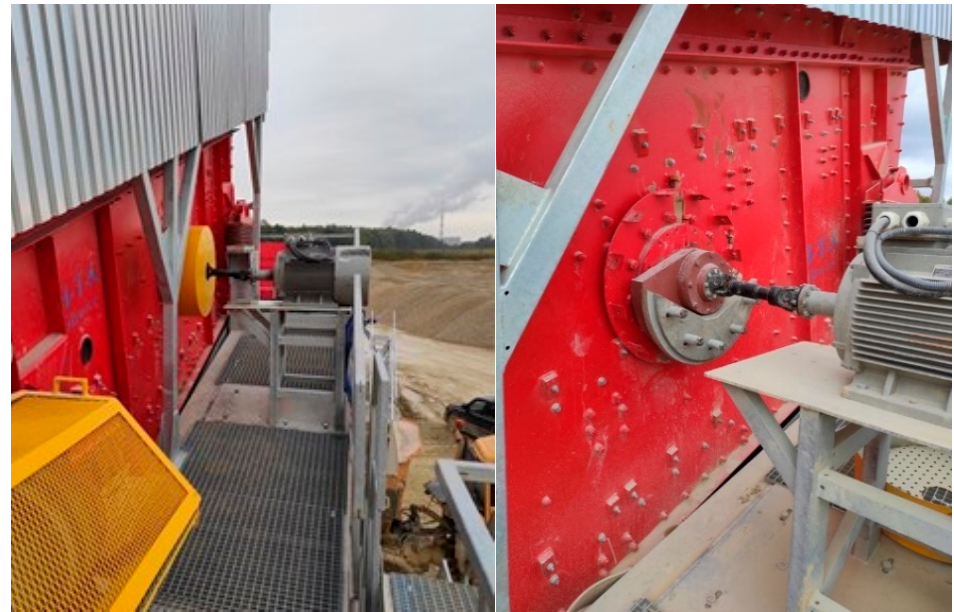
Figure 11. Change of unbalanced masses on the eccentric shaft of the screen. Table 9. Operating parameters of WSR screen.